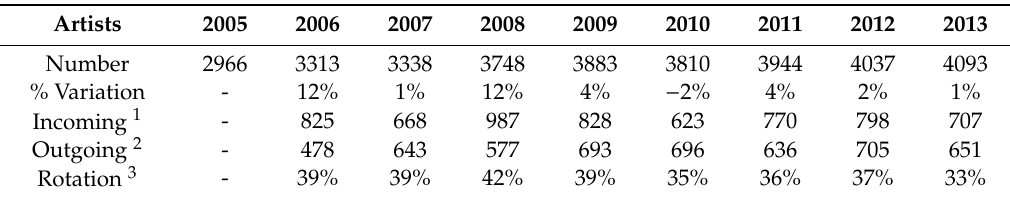
Table 3. Number of artists at the Art Basel fair.